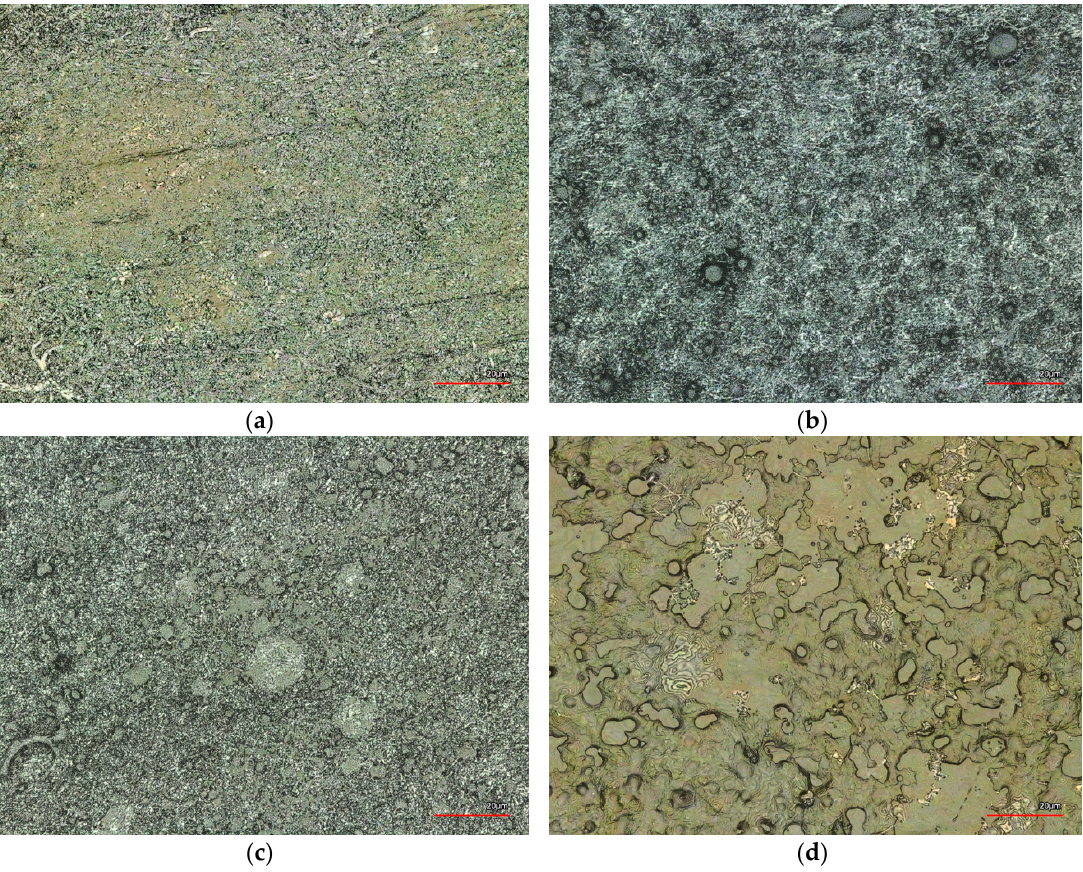
Figure 8. CLSM images of ( a ) an ultrasonic welding seam prepared with the omega pattern; PAN nanofiber mats pressed at different temperatures for 1 min at 1.2 bar: ( b ) 200 °C; ( c ) 220 °C; ( d ) 250 °C. All scale bars show 20 µm.